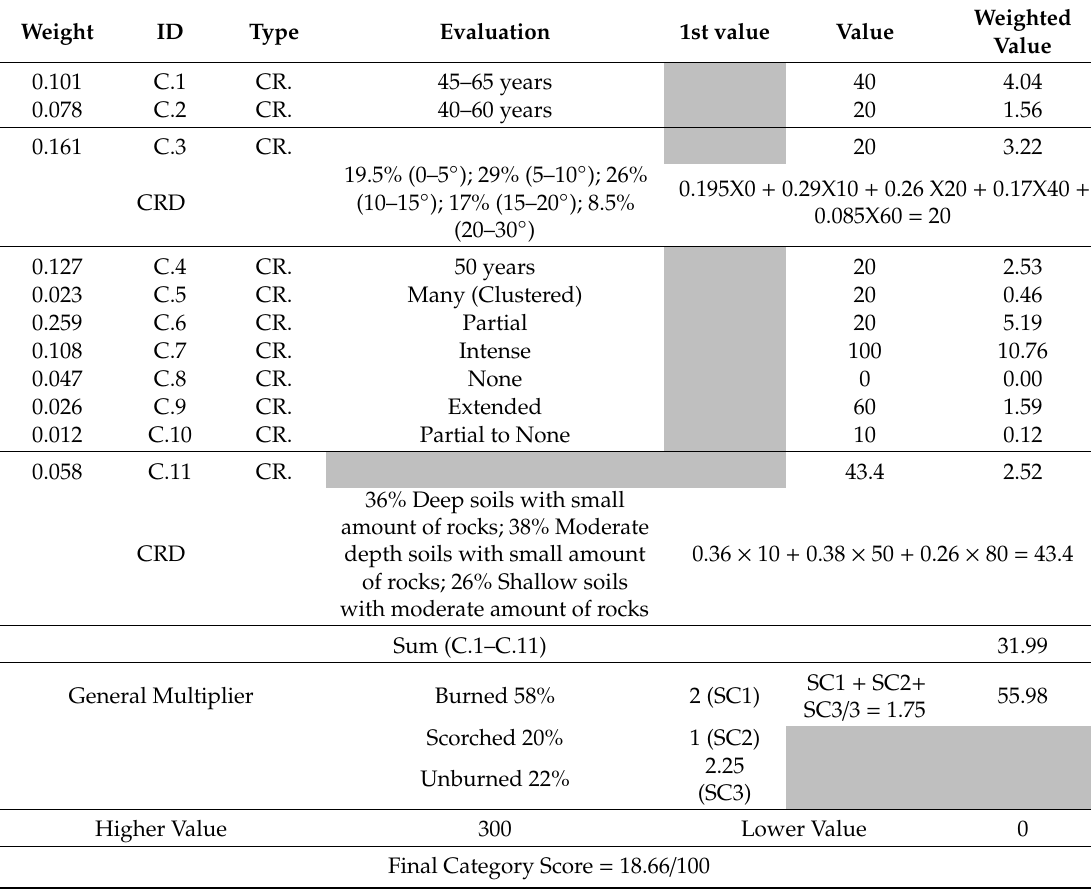
Table A17. Evaluation table of regeneration potential and vegetation recovery after the Evros fire. CR: criterion; CRD: criterion descriptor; SC: Summed score. Original matching table: A3. Gray